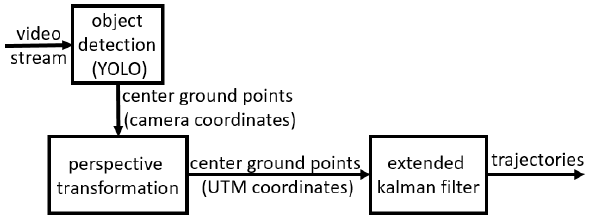
Figure 1. Surveillance camera pipeline